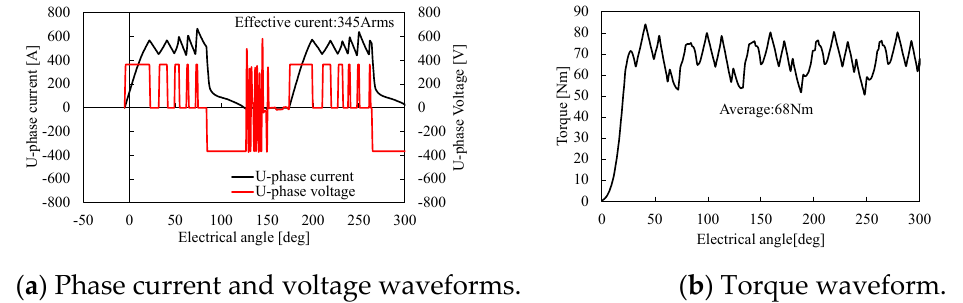
Table 4. Specifications of IM.